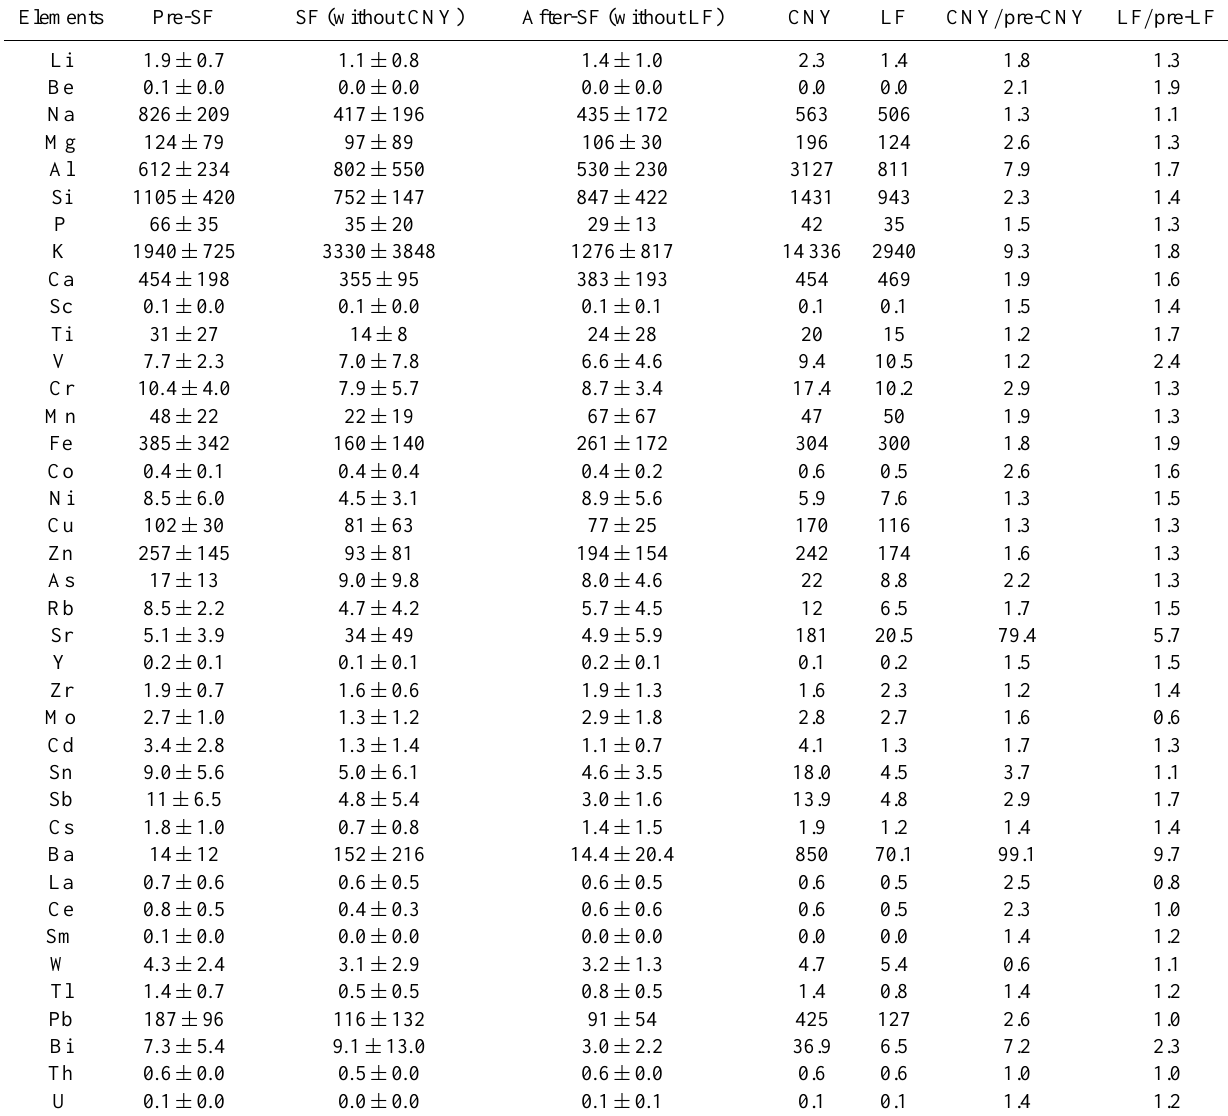
Table 1. Mass concentrations of elements in PM 2 . 5 before, during and after the 2014 Chinese Spring Festival in Nanjing (ngm − 3 ).